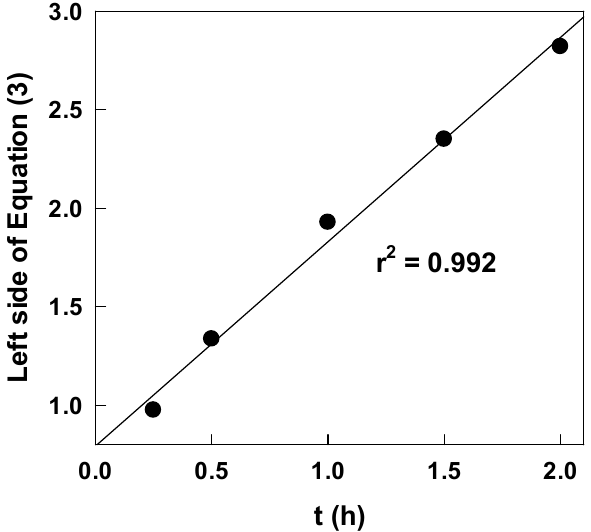
Figure 4. Plots based on Equation (3) to determine rate